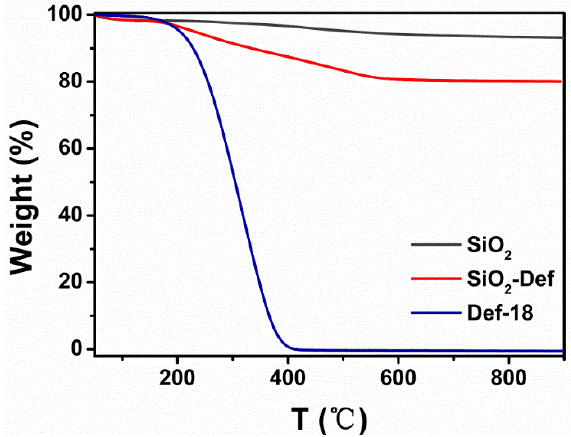
Figure 7. TGA curves of SiO 2 , Def-18, and SiO 2